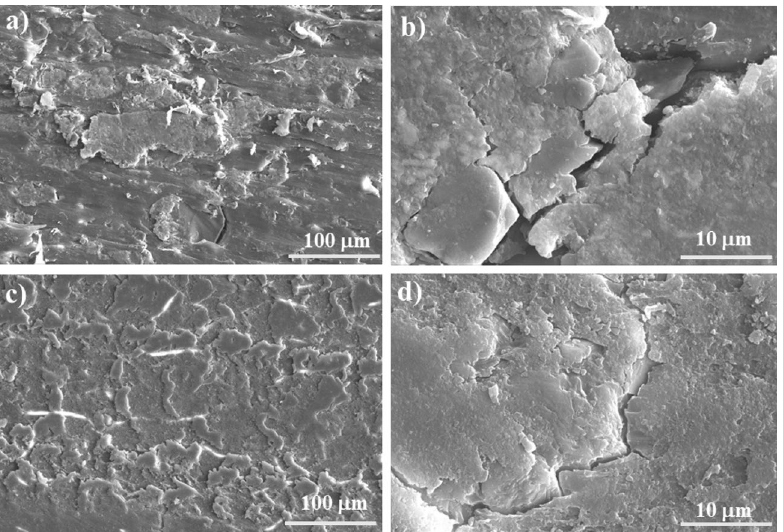
Figure 9. Scanning electron microscope images of wear tracks after 7000 m of sliding: ( a ), ( b ) PA6/Al 2 O 3 -70, ( c ), ( d ) PA6/Zeo-70.